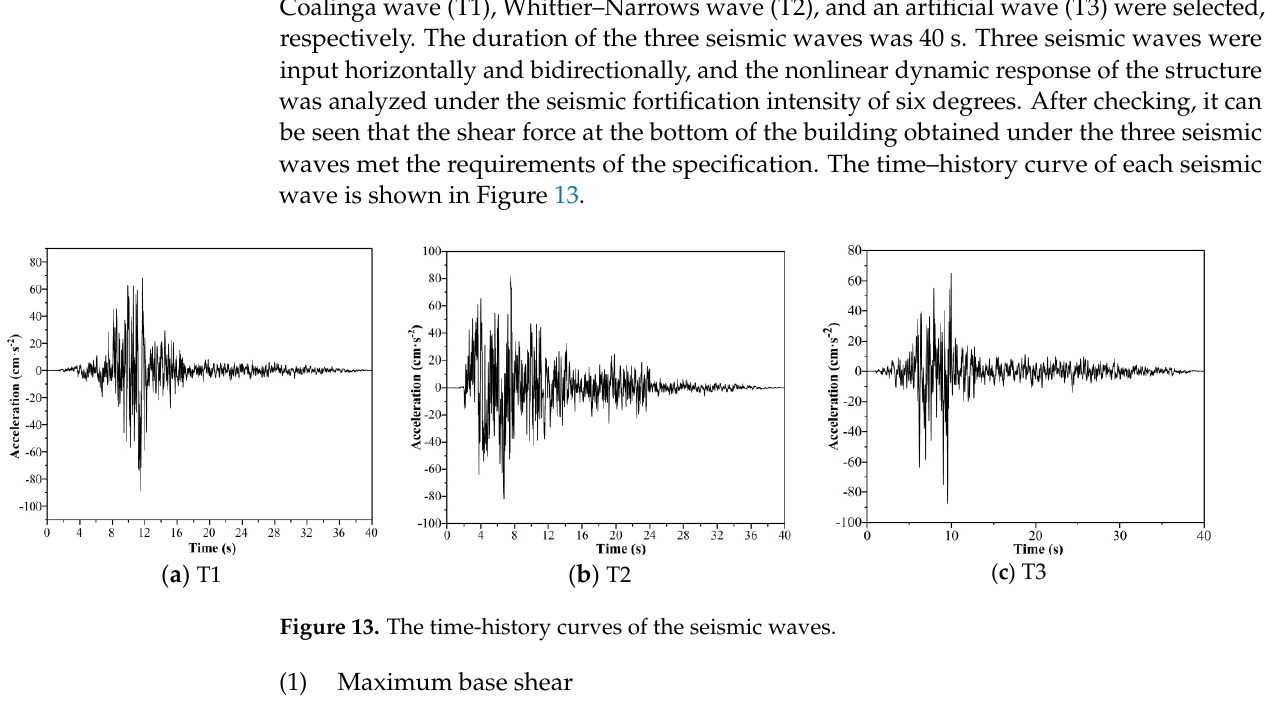
Table 8. The maximum base shear in the X-direction.